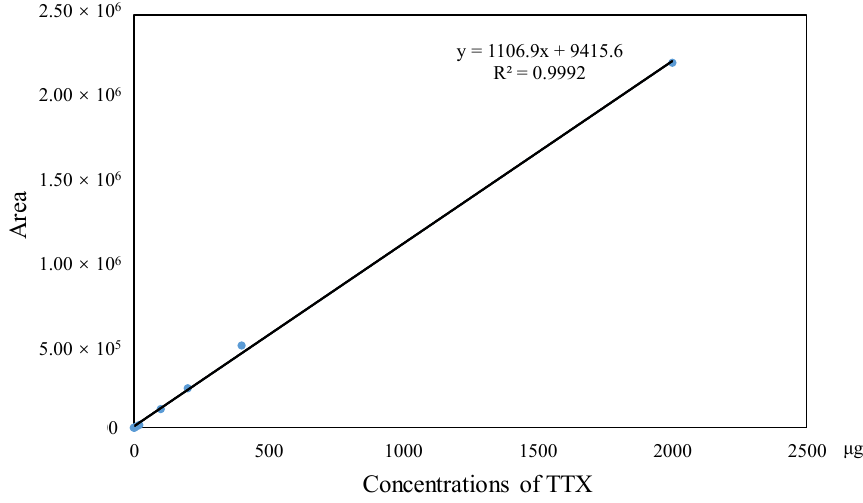
Figure 4. Linear calibration curve of TTX. Table 2. Matrix effects of various tissues at different TTX concentration levels.